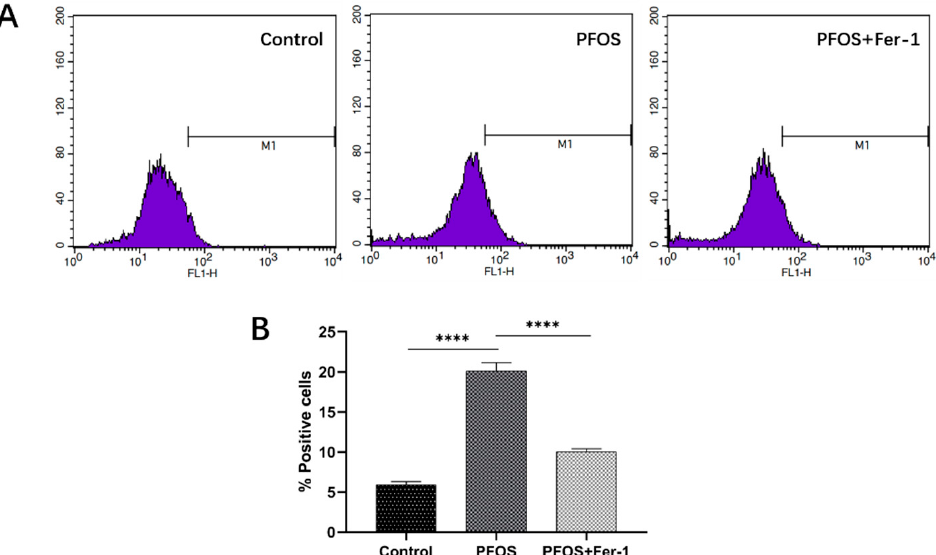
Figure 4. ( A ) ROS production determined by flowcytometry. HK-2 cells were exposed to PFOS at 200 µ M for 12 h or/and cultured with Fer-1 at 1 µ M for 2 h prior to exposure to PFOS. The excitation wavelength and emission wavelength were 488 nm and 525 nm, respectively. ( B ) Comparison of fluorescence intensity in HK-2 cells exposed to PFOS or/and Fer-1. HK-2 cells were exposed to PFOS at 200 µ M for 12 h or/and cultured with Fer-1 at 1 µ M for 2 h prior to exposure to PFOS; the results were from three independent experiments. Data were expressed as mean ± SD (n = 3); **** p < 0.0001.